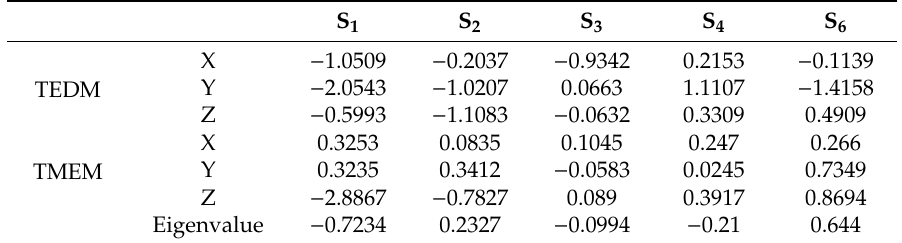
Figure 8. The transition ( a ) electric / magnetic ( b ) dipole moment matrix (upper) and density (under) isosurface of S 6 in PM567. The yellow and purple isosurfaces stand for the positive and negative transition electric dipole moments, respectively, and the red and blue isosurfaces stand for the positive and negative transition magnetic dipole moments, respectively. Table 1. The value of transition electric/magnetic dipole moment and the eigenvalue of their tensor product. S 1